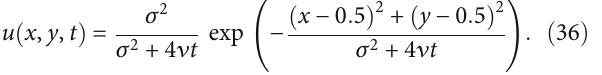
= 10 . Uniform spaced nodes (left) and circular nodes (right), with Neumann t